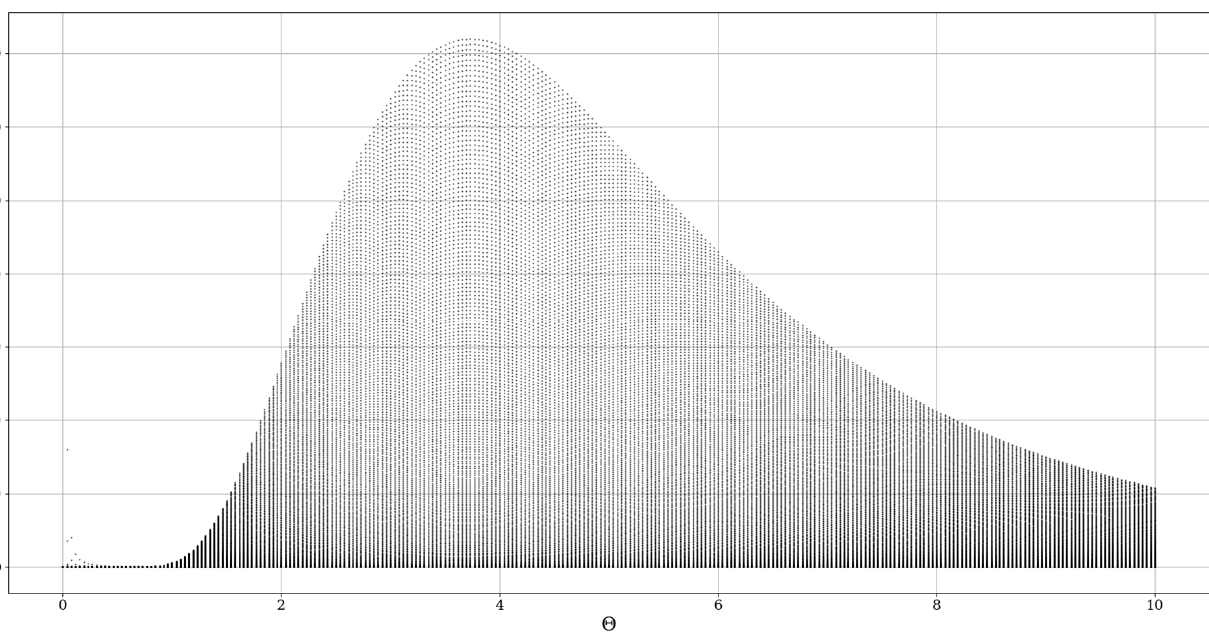
9 of 22 Figure 4. Example plot of ψ(x, t) ; ω constant odd integer.